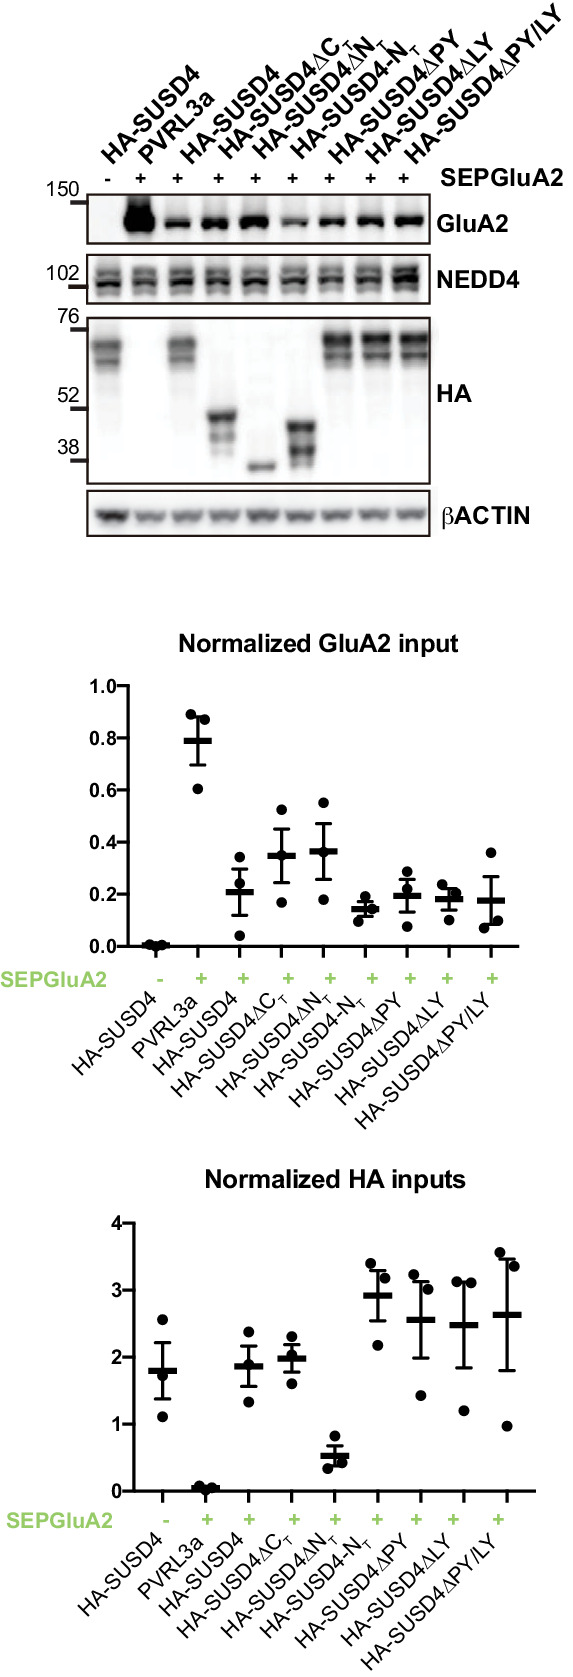
Total protein levels in HEK293 cells transfected with SEP-GluA2 and different SUSD4 mutant constructs (related to Figure 5C and D).HEK293 cells were transfected with SEP-GluA2 together with PVRL3α as a control or one of the HA-SUSD4 constructs for co-immunoprecipitation experiments. Input extracts were probed for GluA2 (with an anti-GluA2 antibody), the HECT ubiquitin ligase NEDD4 (anti-NEDD4 antibody), and the HA-tagged SUSD4 constructs (anti-HA antibody). βACTIN was used as a loading control. Representative image of N = 3 independent experiments. Quantifications represent the GluA2 or HA band intensity normalized to the intensity of the βACTIN band.